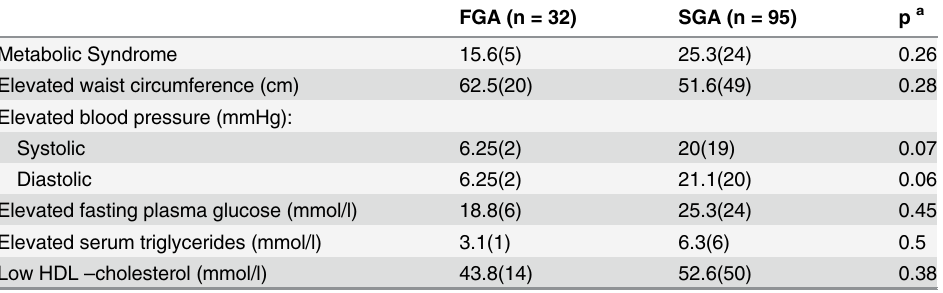
Table 5. The prevalence of metabolic syndrome and individual components according to class of medication in subjects on antipsychotic